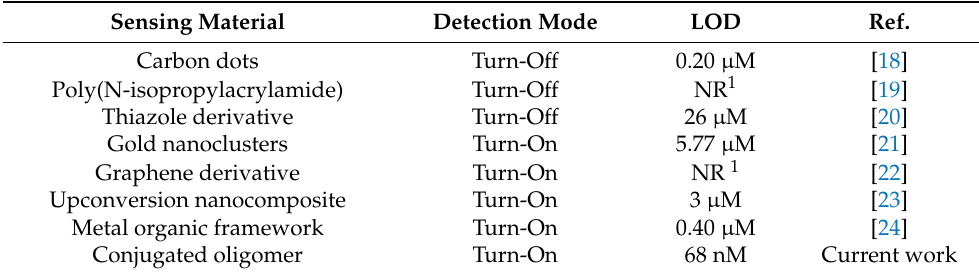
Table 1. Comparison of some previously reported fluorometric sensors of cholesterol with those of the current study. Sensing Material Detection Mode LOD Ref. Carbon dots Turn-Off 0.20 µ M [18] Poly(N-isopropylacrylamide) Turn-Off NR 1 Thiazole derivative Turn-Off 26 µ M Gold nanoclusters Turn-On 5.77 µ